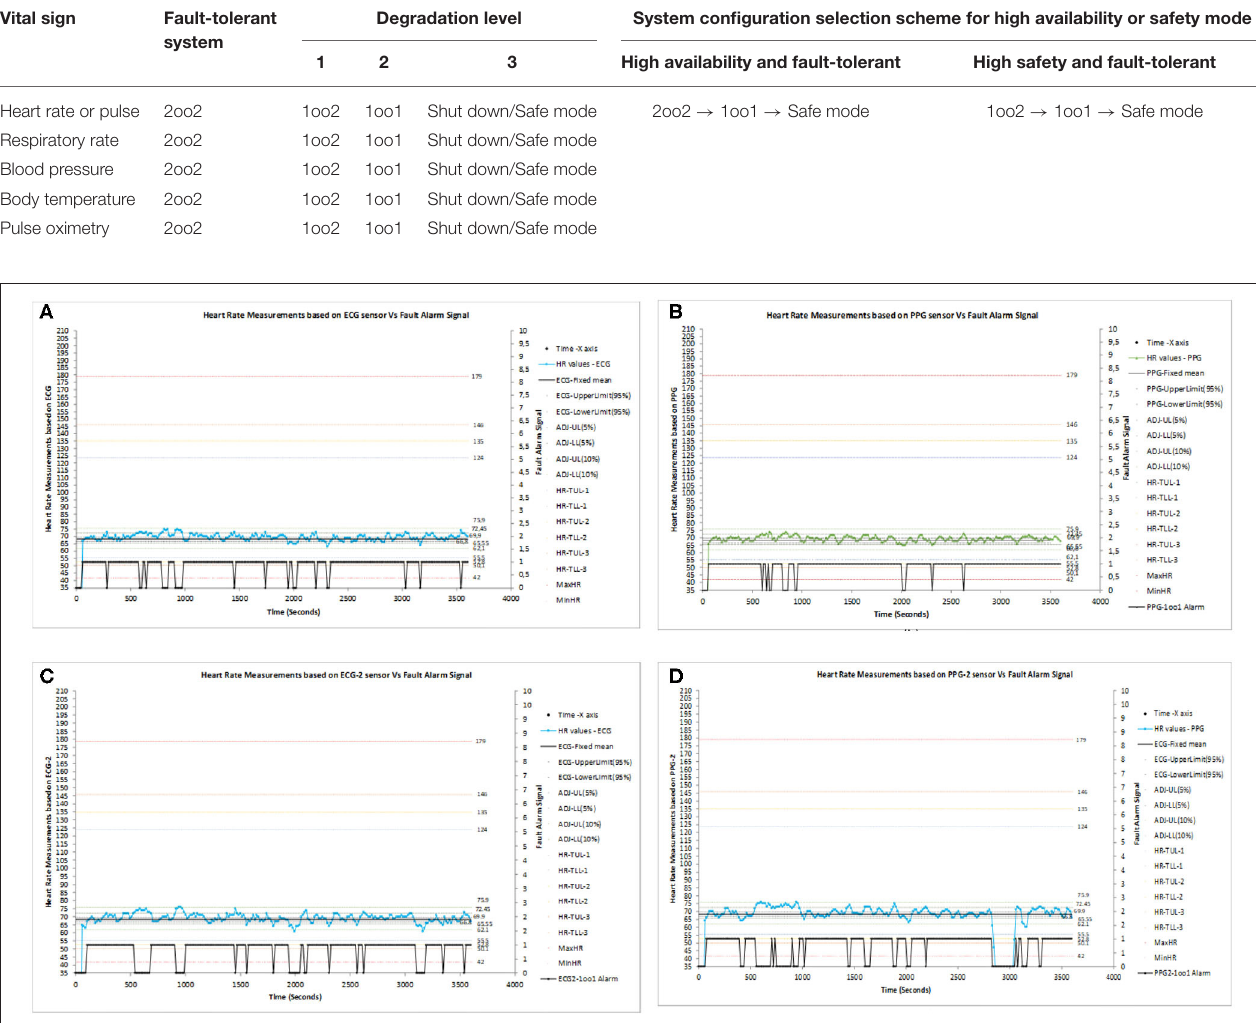
Frontiers in Medical Technology |